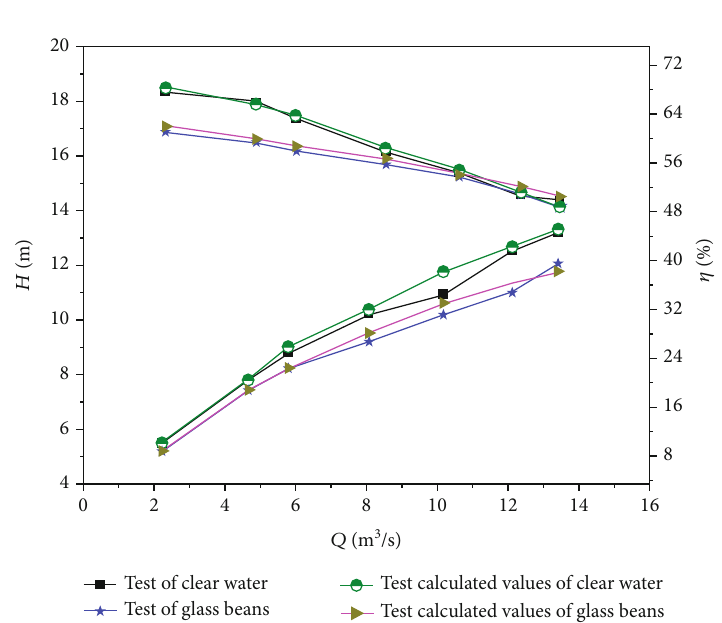
Figure 3: Comparison of the calculated performances with the experimental values.